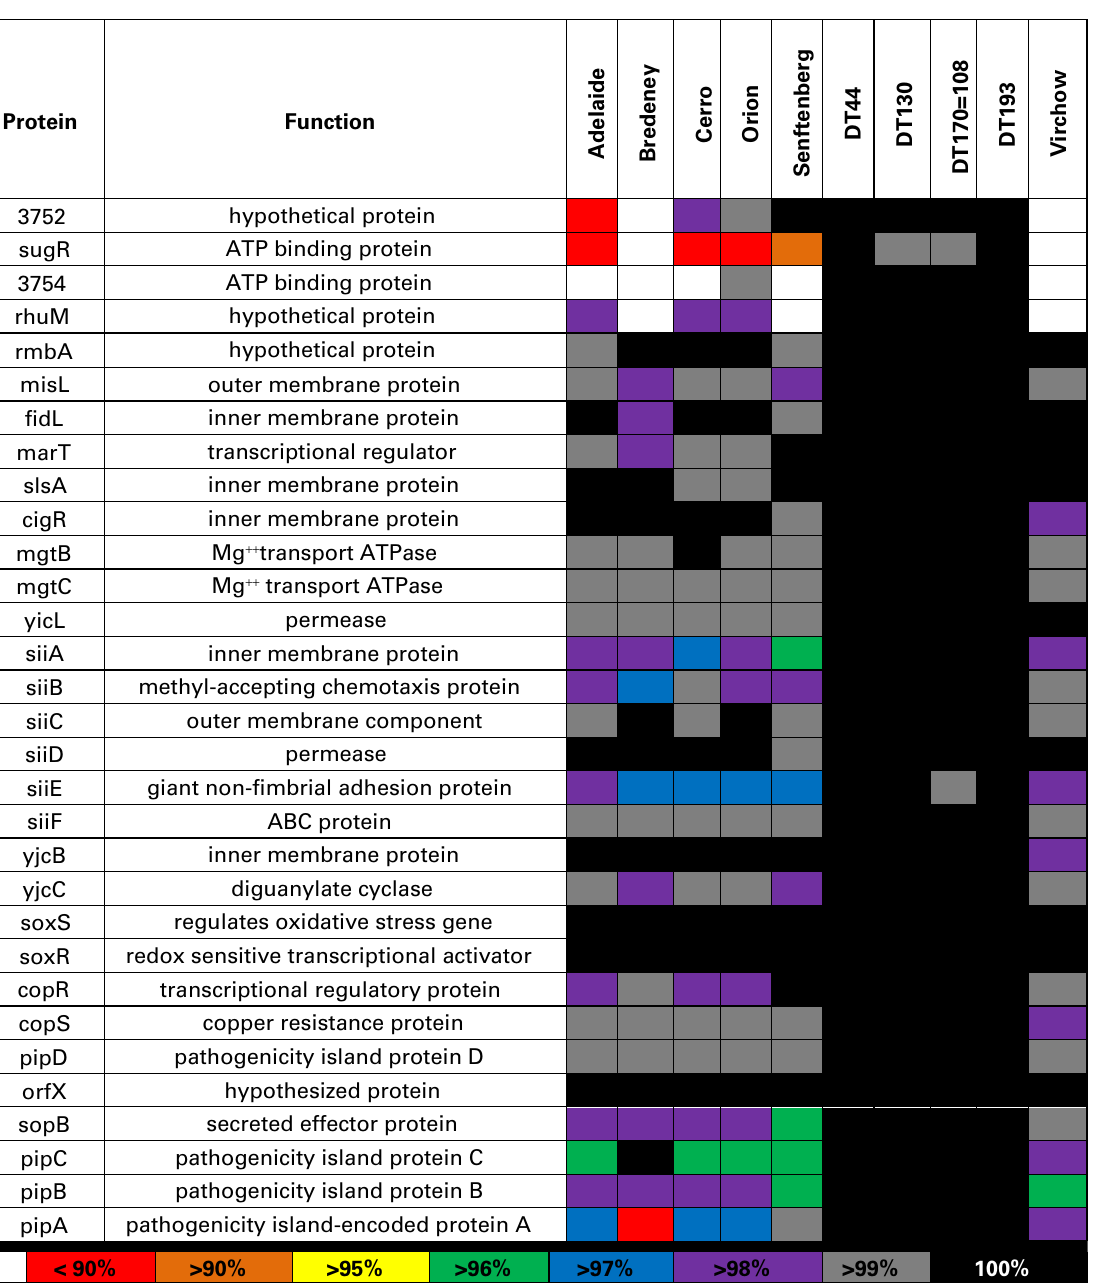
Table 6 | Amino acid variability of SPI-3, -4 and